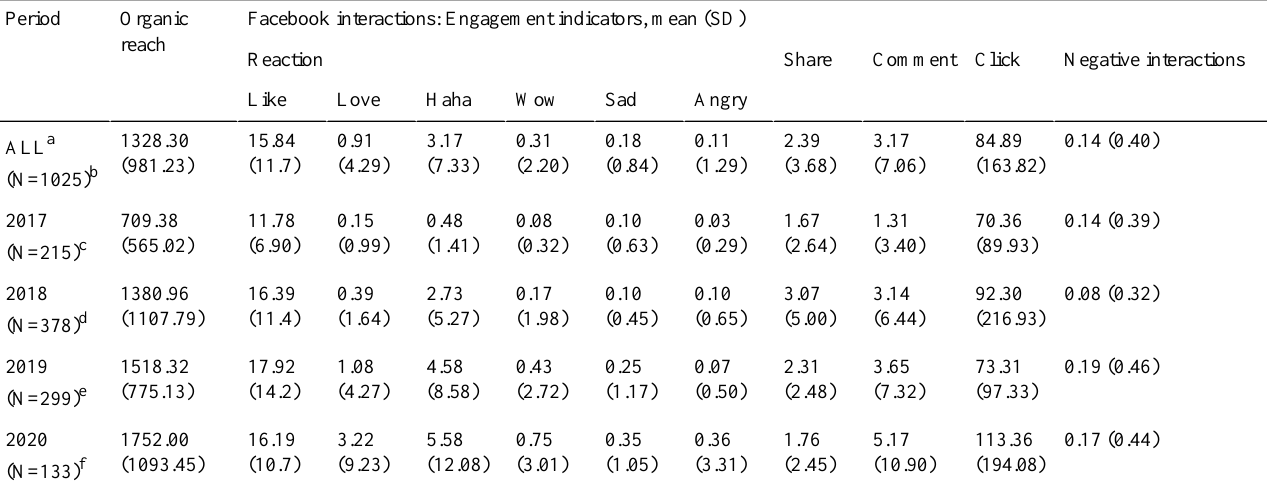
Table 1. Mean and SD of organic reach and Facebook interactions in the research period together and separately for each year.